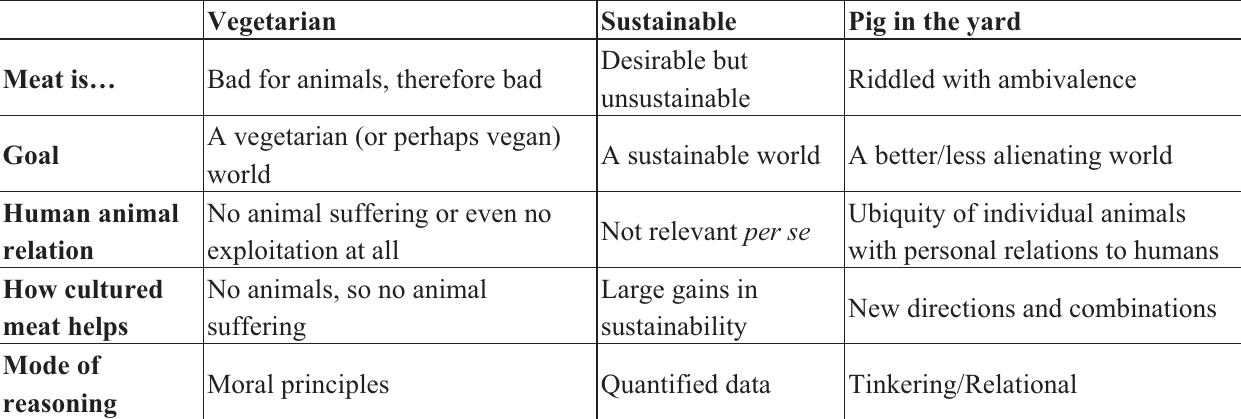
Table 2. Three moral profiles for cultured